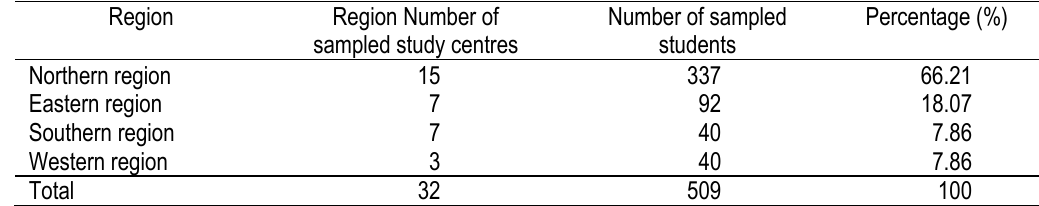
Table 1. Region-wise Distribution of Sampled Study Centres and Learners Region Region Number of Number of sampled Percentage (%) sampled study centres students Northern region 15 337 66.21 Eastern region 7 18.07 Southern region Western region